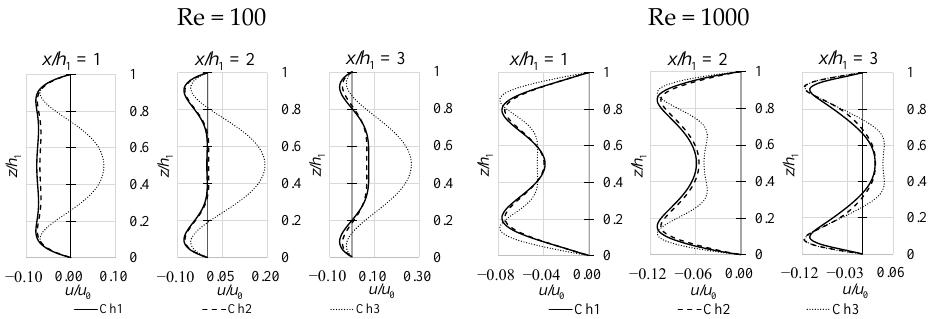
Figure 12. Velocity u profiles at the x – z plane height of y / h 1 = 0.5.